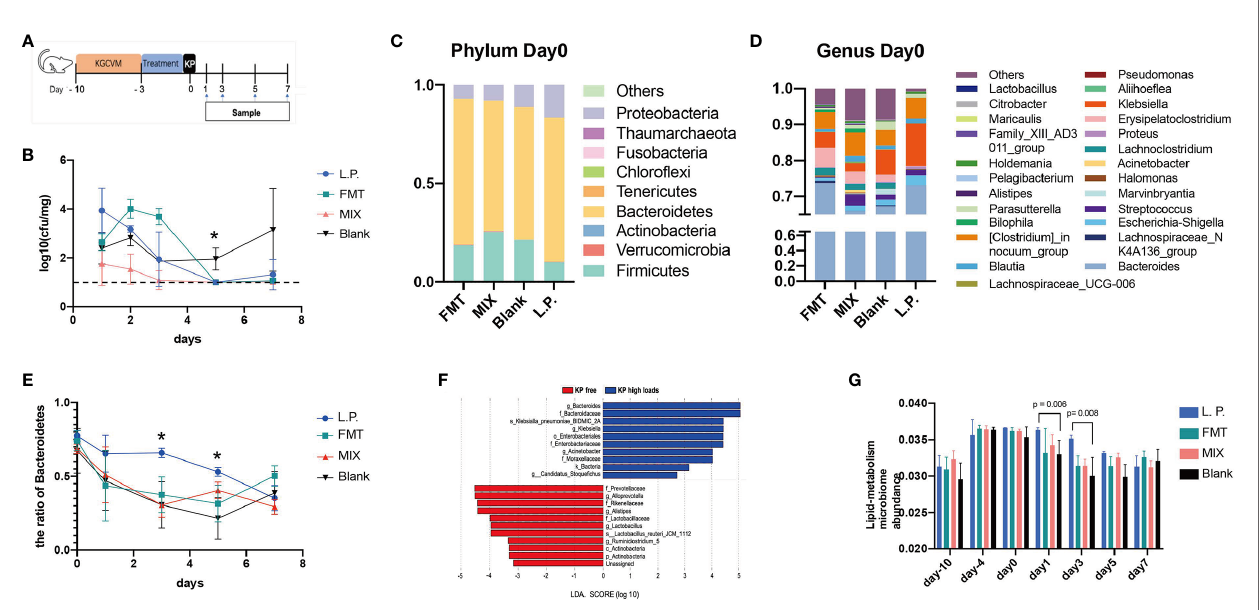
FIGURE 3 | CRKP anticolonization experiments and 16S analysis. (A) Schedule design for animal trails. (B) The anti-CRKP assay fi ndings. The Y-axis represents loads of CRKP strains in mouse feces (n = 4). The limit of detection is represented by the imaginary line. Blank represents the negative control, whereas FMT represents the positive control. L.P. means inoculating mice with L. plantarum LP1812, FMT stands for fecal microbiota transplantation, and MIX refers to pretreatment mice with mixtures of LP1812 and FMT suspensions. The percentages of intestinal microbiota community abundance at the Phylum (C) and Genus (D) levels. The relative abundances of various bacteria were calculated by averaging the data from fi ve/four replicates within each group (FMT and Blank have four mice, L.P. and MIX have fi ve mice) obtained from 16S OTU tables. (E) The ratio of Bacteroidetes in mouse intestinal microbiome calculated from the OTU tables. (F) LEfSe analysis between two groups that were re-classi fi ed in OTU tables based on loads of CRKP ZKP25. (G) The lipid metabolism relative microbiome ratios in feces microbiomes. The ratios were obtained from KEGG analysis. *denotes p-value < 0.05.